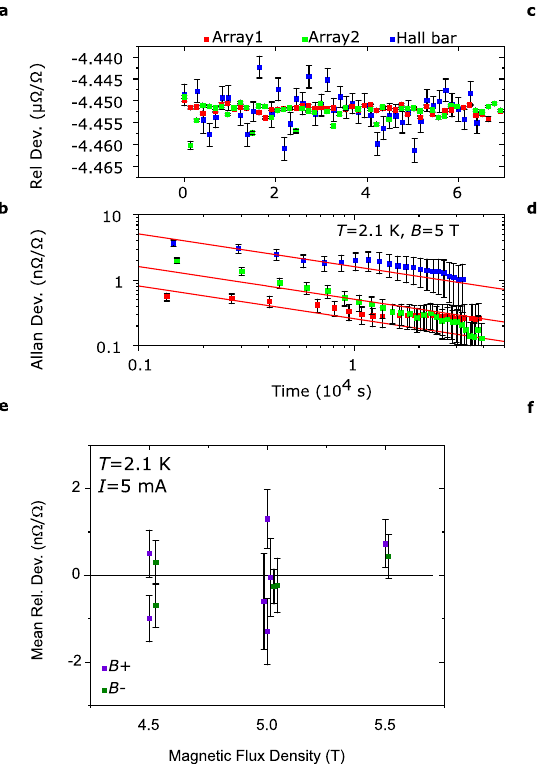
Fig. 4 | Indirect and direct comparison between array and standard Hall bar. a Precisionmeasurementsofa100 Ω resistancestandardusingbothastandardHall bar(blue)andtwosubarrays(Array1redandArray2green).The100 Ω isbiasedwith 3mA and the Hall bar and subarray receive 23 μ A and 2.75mA respectively. The graph shows three different sets of cryogenic current comparator (CCC) readings ofrelativedeviations,withonestandarddeviationerrorbars. b Thecorresponding Allan deviations, with estimated relative error (see Methods). The red line shows the corresponding Allan deviation for pure white noise. The mean relative devia- tions are Δ HB-100 = ( − 4.4521±0.0019) μΩ / Ω , Δ Array1-100 =( − 4.4519±0.0003) μΩ / Ω and Δ Array2-100 = ( − 4.4522±0.0005) μΩ / Ω , with standard deviation of the mean taken from Allan at 10 4 s. c Example of a direct comparison between Hall bar and one subarray. The top graph contains relative deviation data and error bars